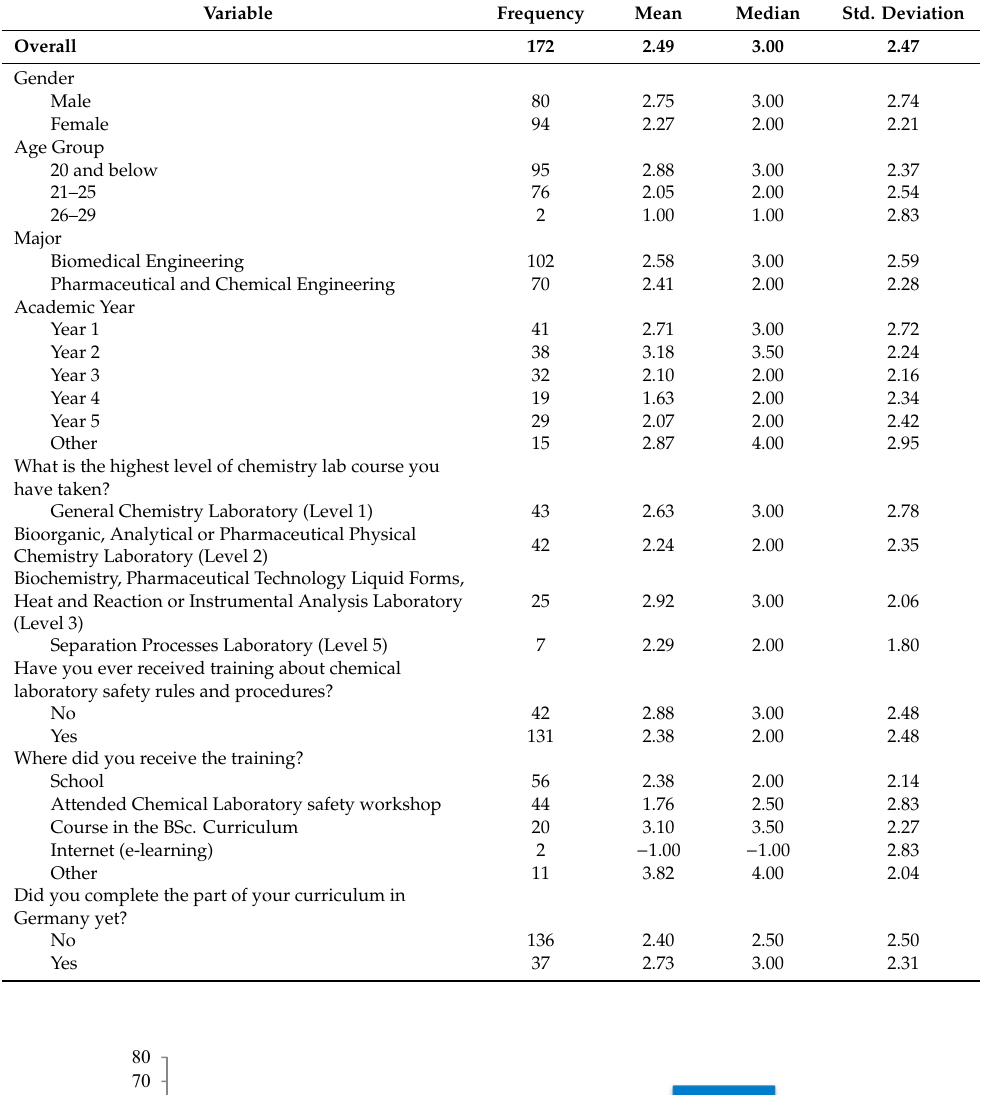
Table 3. Descriptive statistics for the attitude scores by selected demographics.